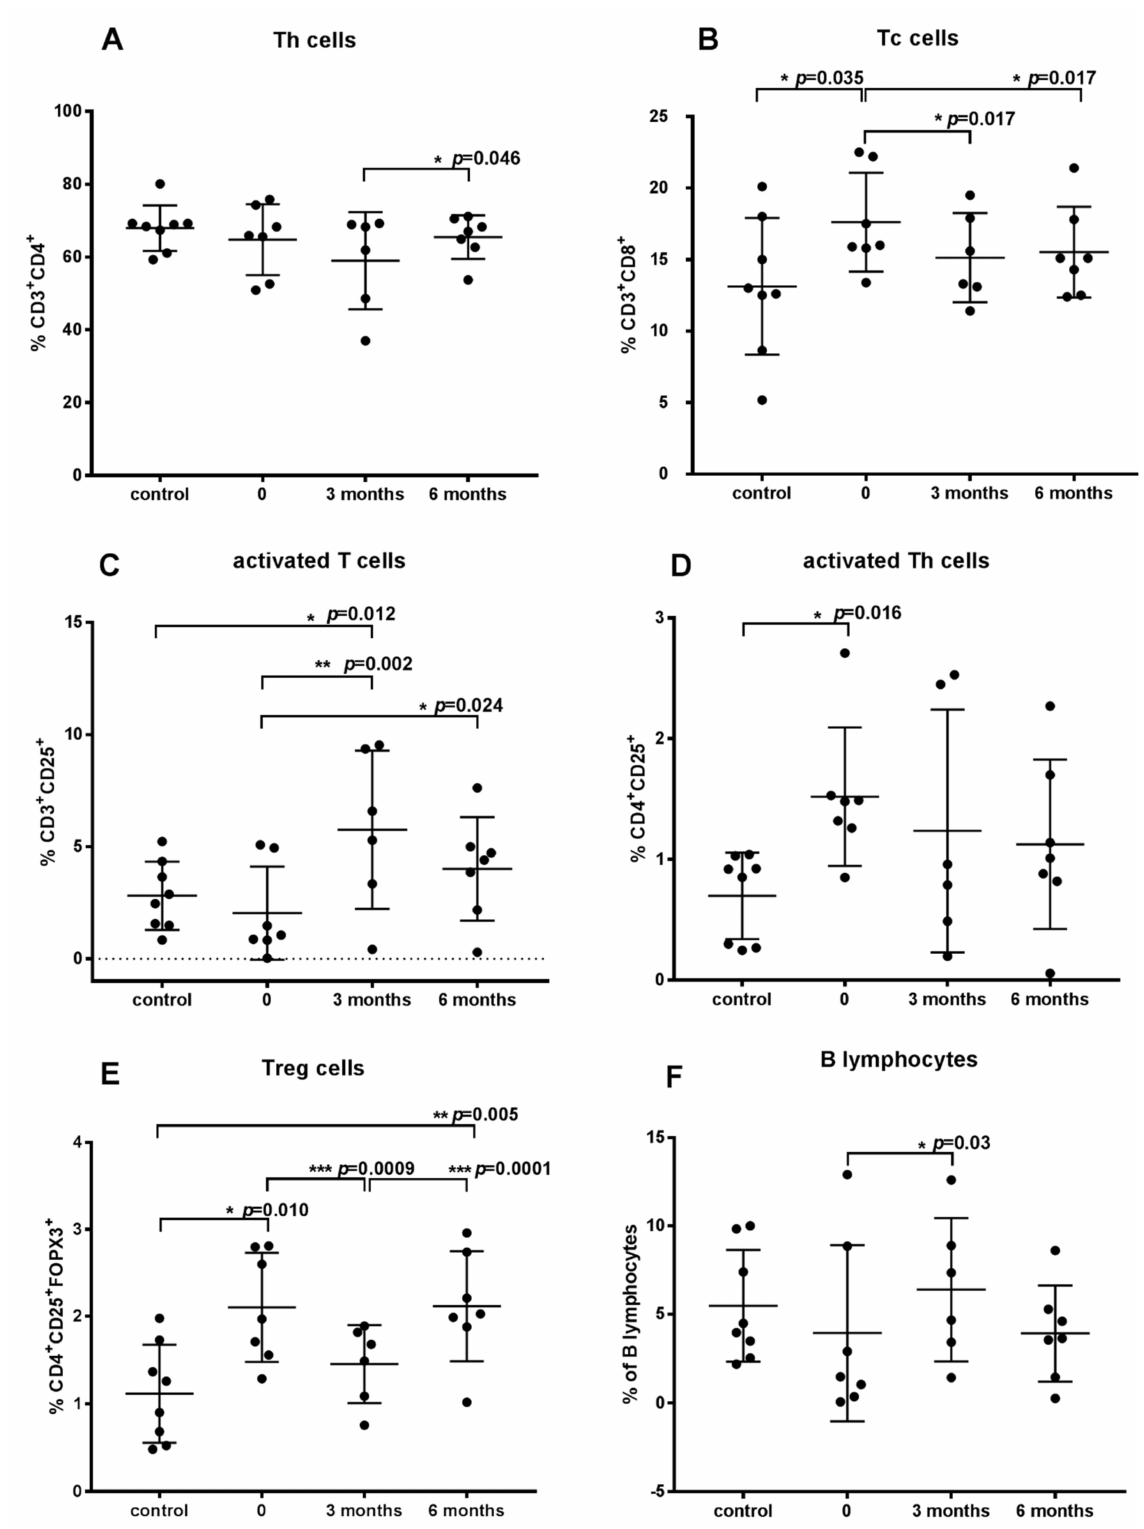
Figure 2. Percentage of lymphocyte subsets in peripheral blood of dogs with atopic dermatitis before ASIT (0), after 3 and 6 months of therapy, and in healthy dogs (control): ( A ) T helper cells, ( B ) T cytotoxic cells, ( C ) activated T lymphocytes, ( D ) activated Th cells, ( E ) Treg cells, ( F ) B lymphocytes. All data represent mean ± standard deviation. Symbols: *, **, *** represents the level of significance, respectively: p < 0.05, p < 0.01, p < 0.001 (repeated measures ANOVA with Fisher’s post-hoc